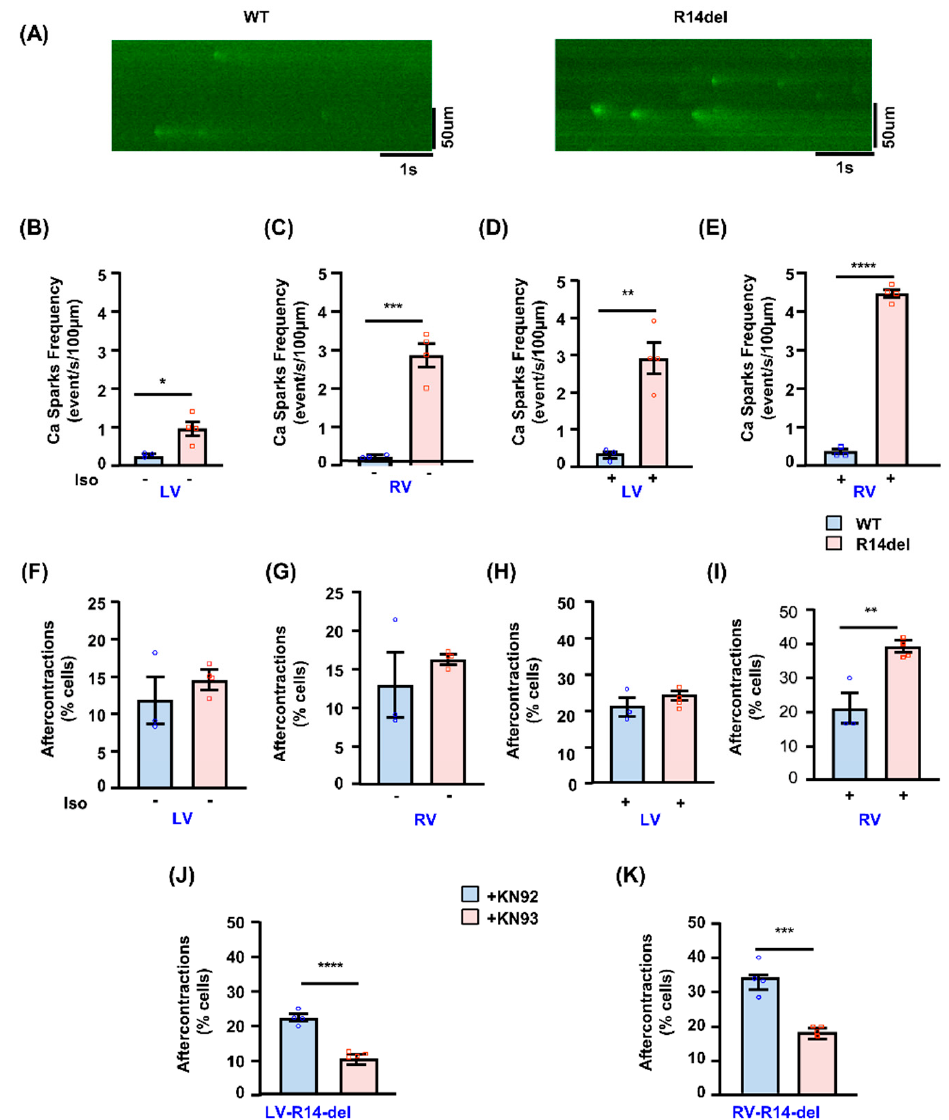
Figure 6. Ca sparks and aftercontractions in R14de-PLN cardiomyocytes. Ca spark characteristics in isolated LV and RV myocytes. ( A ) Representative line-scan images of Ca sparks in RV myocytes in the presence of 100 nmol/L isoproterenol. ( B , C ) Mean data of Ca spark frequency under basal conditions. ( D , E ) Mean data of Ca spark frequency in presence of 100 nmol/L isoproterenol (Iso). n = 30 LV and 30 RV cells for WT (N = 3 hearts); n = 30 LV and 30 RV cells for R14del-PLN (N = 4 hearts). ( F – I ) Aftercontractions were assessed in LV and RV myocytes under field stimulation of 2 Hz and in the absence ( F , G ) or presence ( H , I ) of 1 µ mol/L isoproterenol. n = 49 LV and 52 cells RV cells for WT (N = 3 hearts); n = 65 LV and 58 RV cells for R14del-PLN (N = 4 hearts). ( J , K ) Assessment of aftercontractions in presence of CaMKII inhibitor KN93 (1 µ mol/L) or its analog KN92 (1 µ mol/L) as control. n = 57 LV and 54 RV cells for WT (N = 4 hearts and n = 54 LV and 63 RV cells for R14del-PLN (N = 4 hearts). Data are expressed as mean ± SEM, and statistical analyses were performed by Student’s unpaired t -test. * p ≤ 0.05 vs. WT-PLN; ** p ≤ 0.001 vs. WT-PLN; *** p ≤ 0.0001 vs. KN92; **** p ≤ 0.00001 vs. KN92.